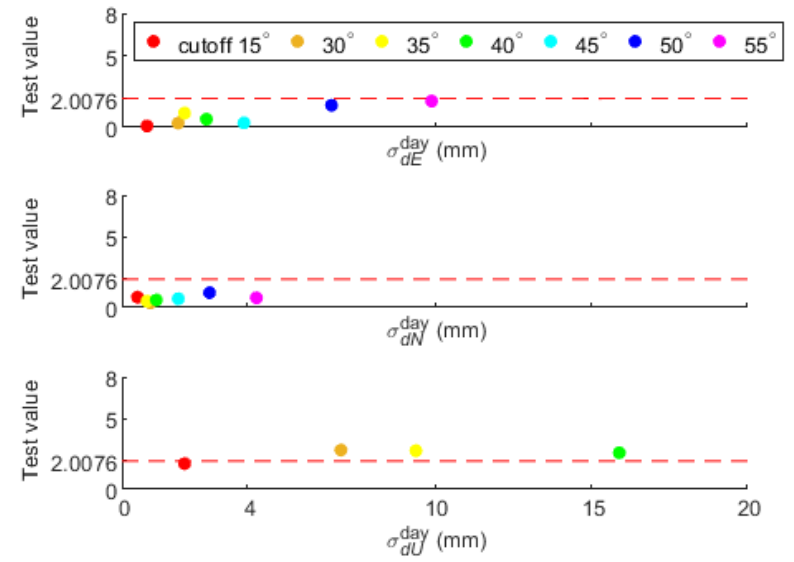
Figure 8. Test values of Student’s t -test for masking conditions level. The azimuth cutoff is from 90° to 270°. The five-constellation PPP is adopted during the process. The top, middle and bottom panels refer to the E, N and U directions, respectively.